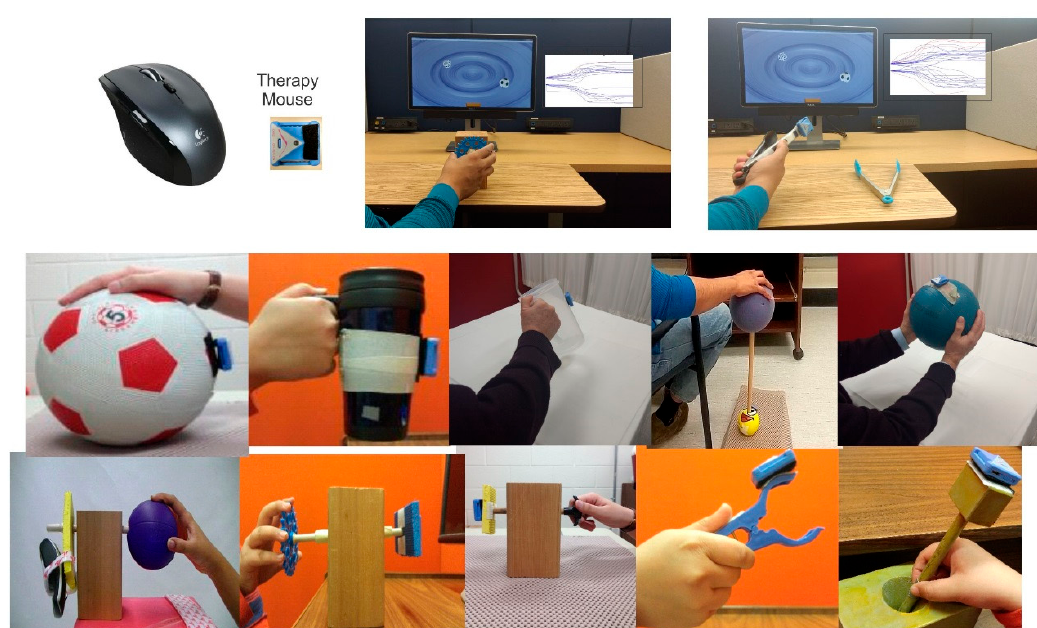
Figure 1. Components of game-based telerehabilitation platform (GTP). Top left panel shows miniature motion mouse (therapy mouse) next to a typical optical mouse. The motion mouse is attached with Velcro to various objects and is used to play computer video games, illustrated in top right panels.